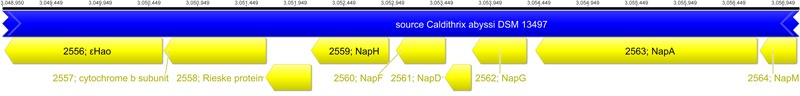
The gene cluster encoding nitrate reductase Nap and putative nitrite reductase 𝜀Hao.